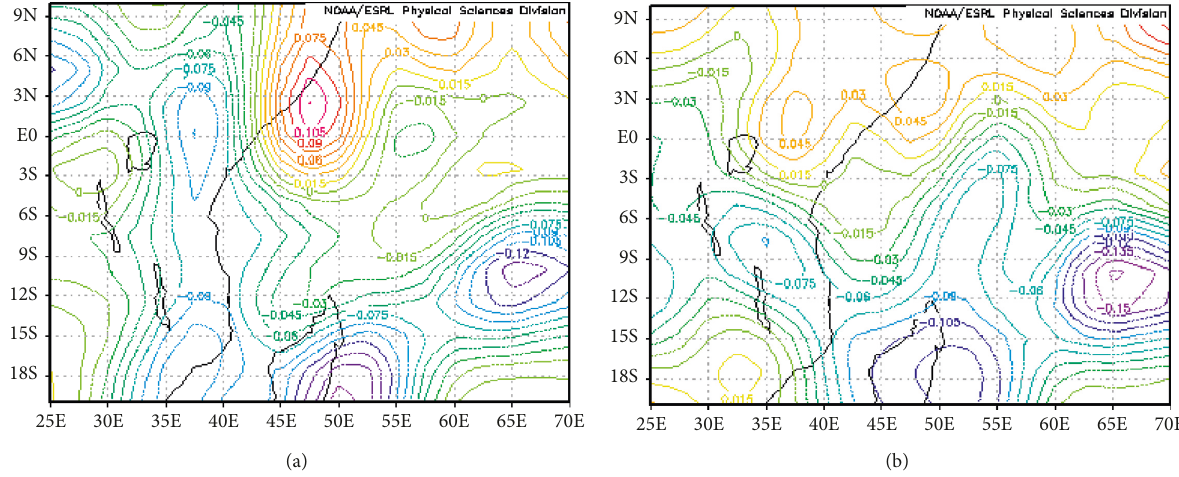
Figure 5: Vertical velocity (Omega) (Pascal/second) for both 850hPa (a) and 500 hPa(b) (images provided by the NOAA-ESRL Physical Sciences Division, Boulder Colorado from their website at